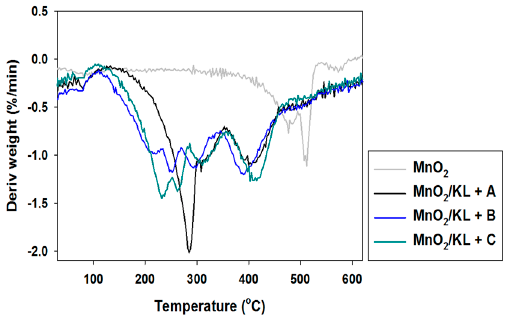
Figure 12. DTG curves of manganese oxide and hybrid materials.